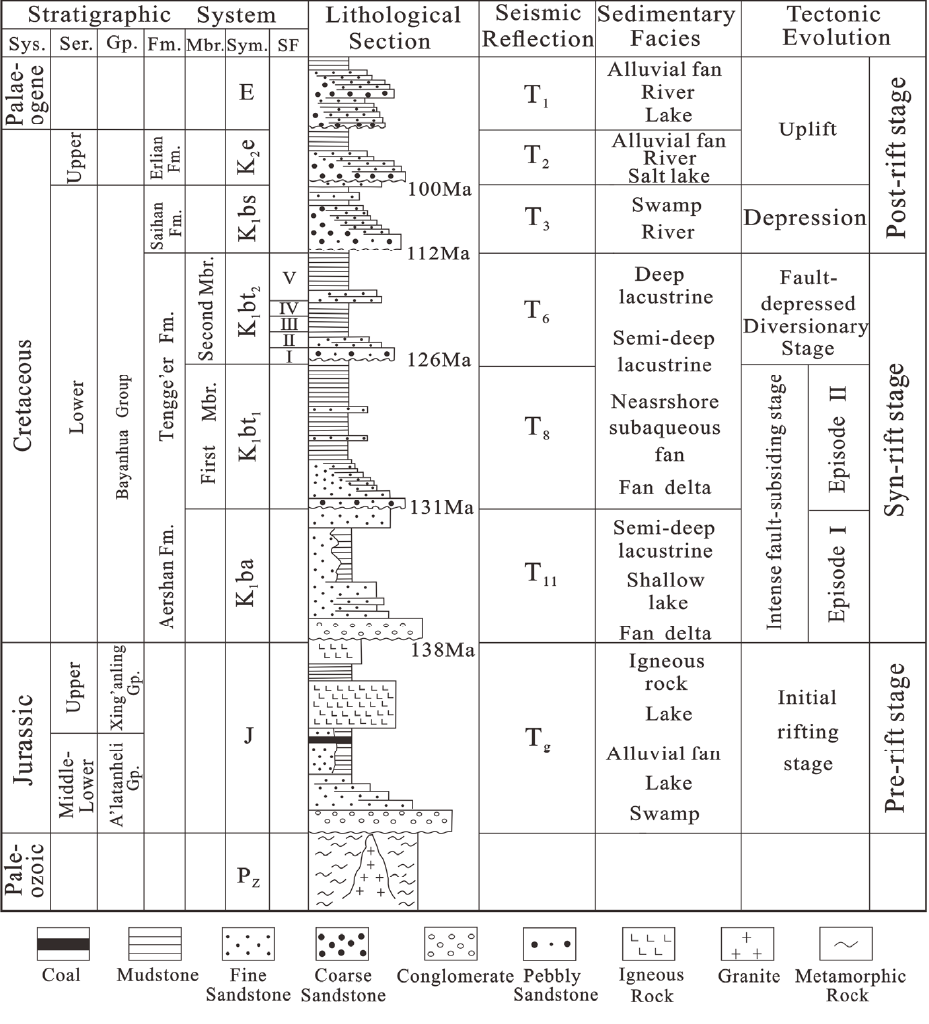
Figure 2. The stratigraphic succession map of Saihantala sag [58]. Abbreviations: Sys.: System; Ser.: Series; Gp.: Group; Fm.: Formation; Mbr.: Member; Sym.: Symble; SF: Sand Formation.